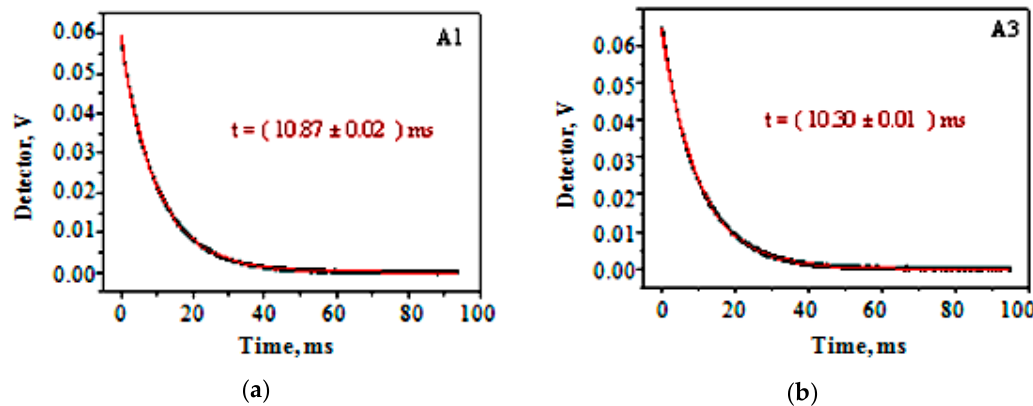
Figure 22. The lifetimes of two EDFs A1 and A3 at pump power of 25 mW.